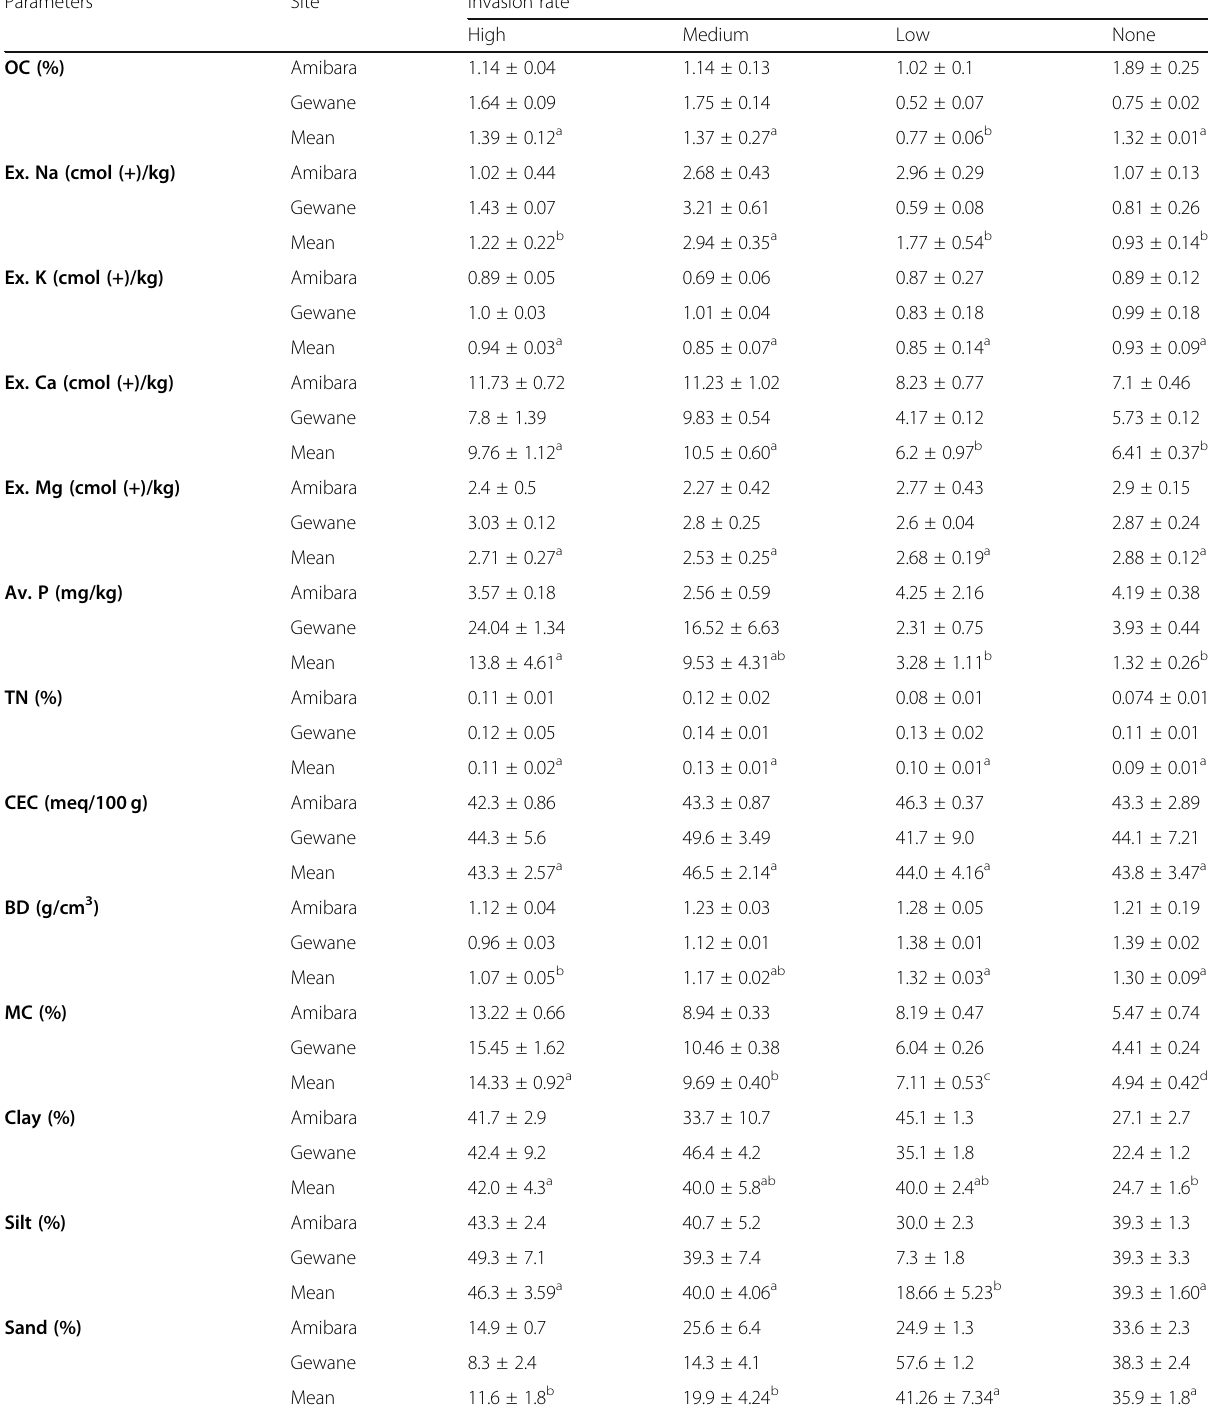
Table 2 The effect of P. juliflora species invasion rate on soil physical and chemical properties